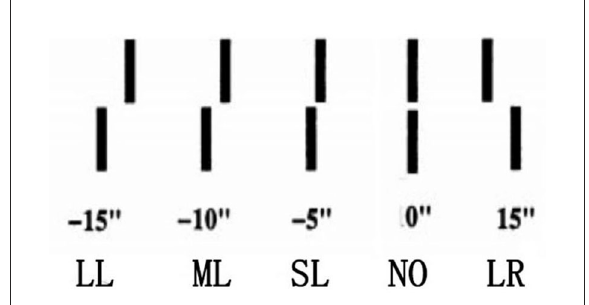
FIGURE1 An example of offsets. From left to right are the conditions of large left offset (LL), middle left offset (ML), small left offset (SL), no offset (aligned verniers, NO), and large right offset (LR),